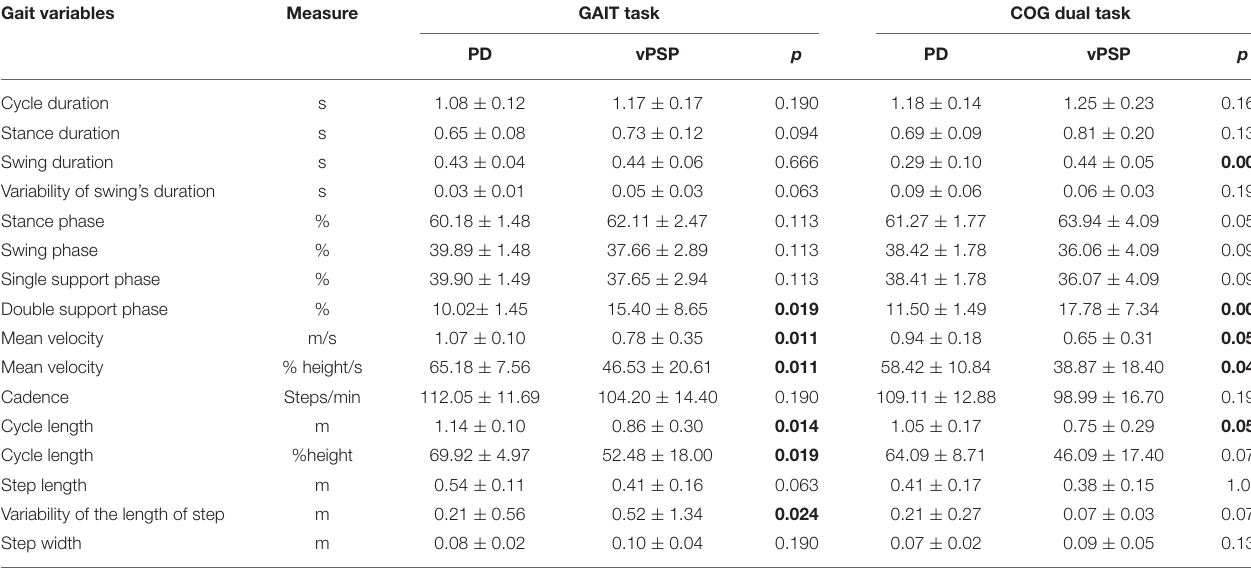
TABLE 6 | Univariate statistical analysis comparing all gait parameters between PD and